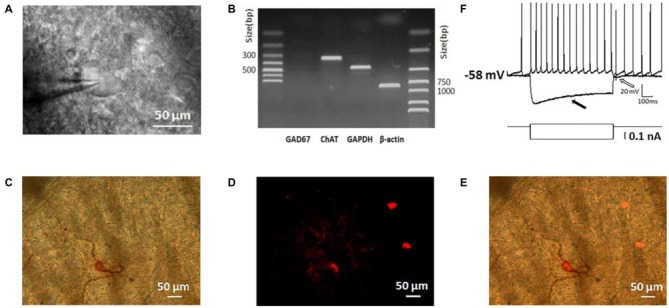
Morphological, physiological, electrophysiological, and immunohistochemical staining characterization of striatal cholinergic interneurons (ChIs). (A) An IR-DIC image of a dorsolateral striatal slice illustrating the characteristic appearance of giant interneurons. (B) ChAT was shown in single-cell reverse transcription polymerase chain reaction (scRT-PCR) experiment product. The absence of GAD 67 indicated aspirated cellular content wasn’t contaminated by MSNs. (C) Micrograph of a giant cell loaded with biocytin and subsequently stained immunohistochemically. (D) Immunofluorescence staining of ChIs in biocytin-loaded slices. (E) Merge of (C) and (D). The targeted cell intracellular loaded biocytin was co-stained by ChAT, inferring the giant aspiny ChIs. (F), Depolarizing somatic current injection elicited a train of regular spiking followed by a large hyperpolarization (indicated by a hollow arrow). Negative current injection caused a large hyperpolarization followed by a sag (indicated by a filled arrow).